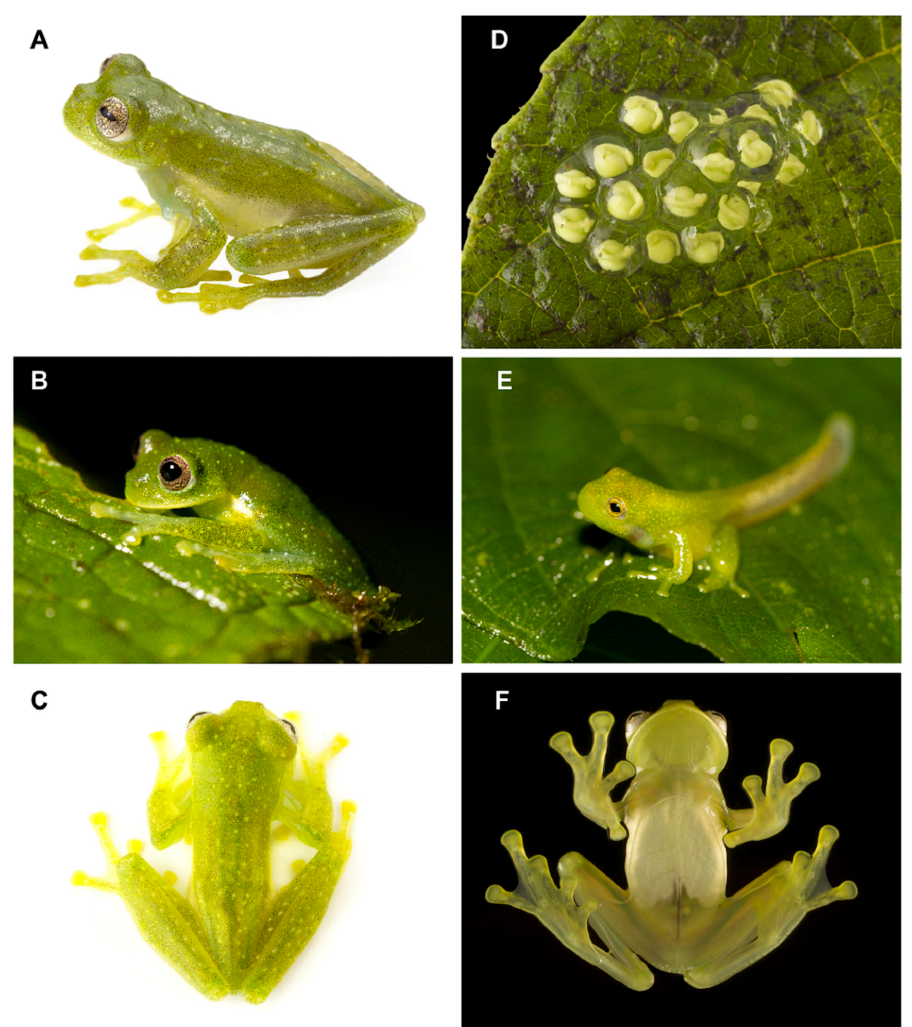
Figure 20. Centrolene ballux in life from Reserva Las Gralarias, Pichincha province, Ecuador. ( A , B ) Adult males. ( C ) Adult male in dorsal view, QCAZ 40199. ( D ) Egg clutch on upper side of leaf. ( E ) Metamorph. ( F ) Adult female in ventral view, QCAZ 40196. Photos by Carl R. Hutter ( B , D , E ), Luis A. Coloma ( C , F ), and Alejandro Arteaga/Tropical Herping ( A ).